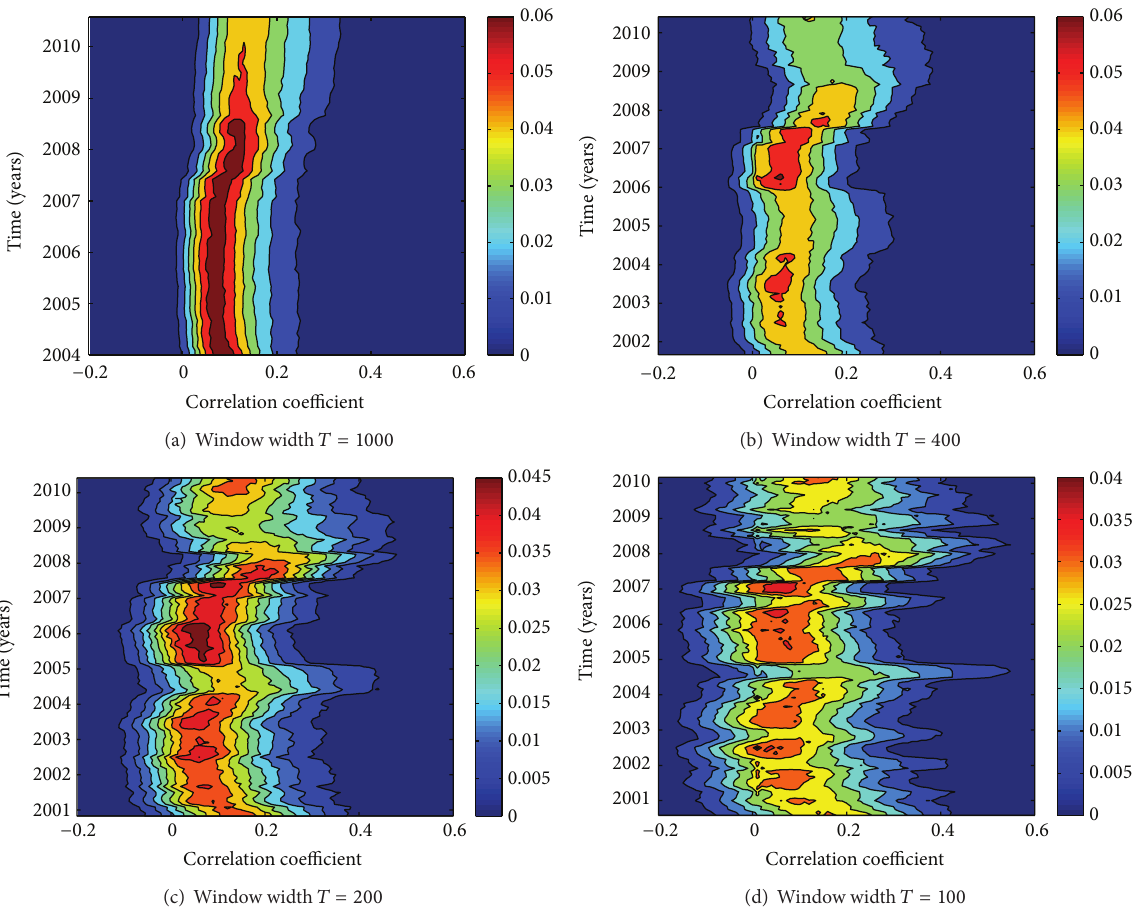
Figure 3: (Color online) Contour plots of probability density functions for correlation coefficients with different 𝑇 values.